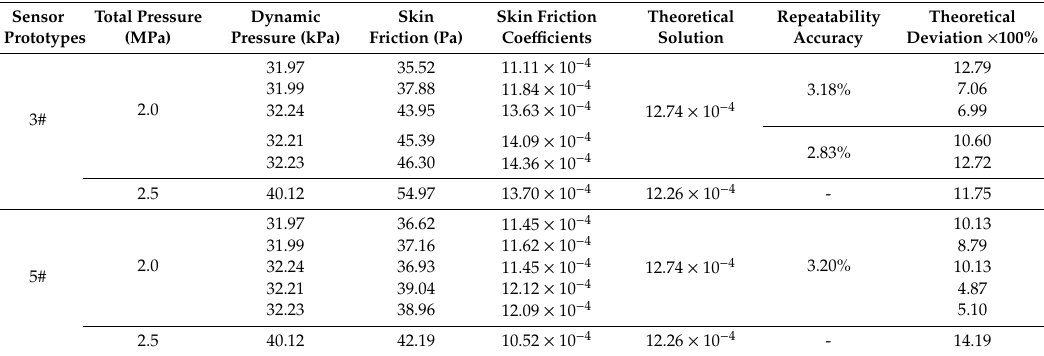
Table 5. The data analysis of repeatability tests in 2.0 and 2.5 total pressure